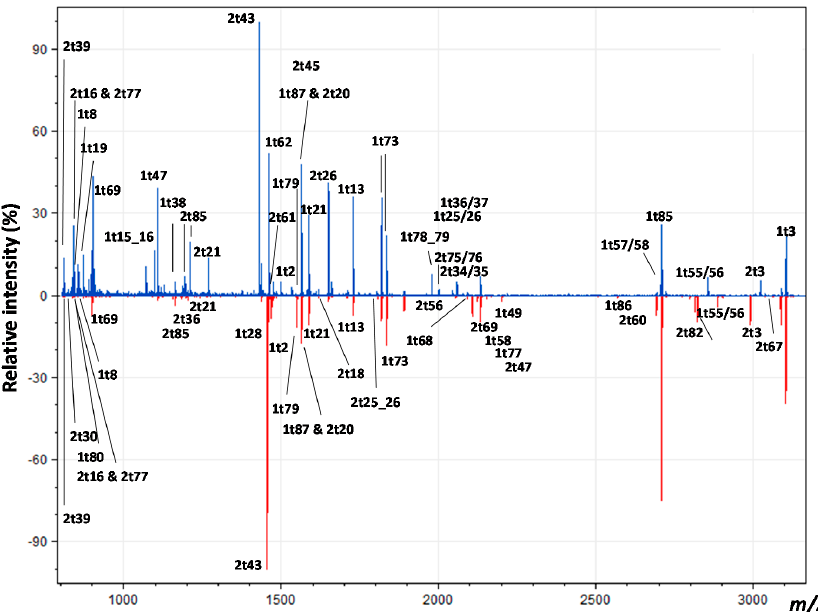
Figure 2. Matrix Assisted Laser Desorption Ionization Time of Flight (MALDI-ToF) mass spectra of collagen tryptic digests from Bos ( top ) and Sus ( bottom ) bone, annotated with peptide labels relating to their position in the α chains. 2t3 is noted as being subject to an additional mass shift due to the change of a proline residue that is predominantly hydroxylated in Bos (“/” indicates missed cleavage site, i.e. , the presence of an internal K or R residue; “&” indicates that more than one peptide are observed with a similar m / z value).